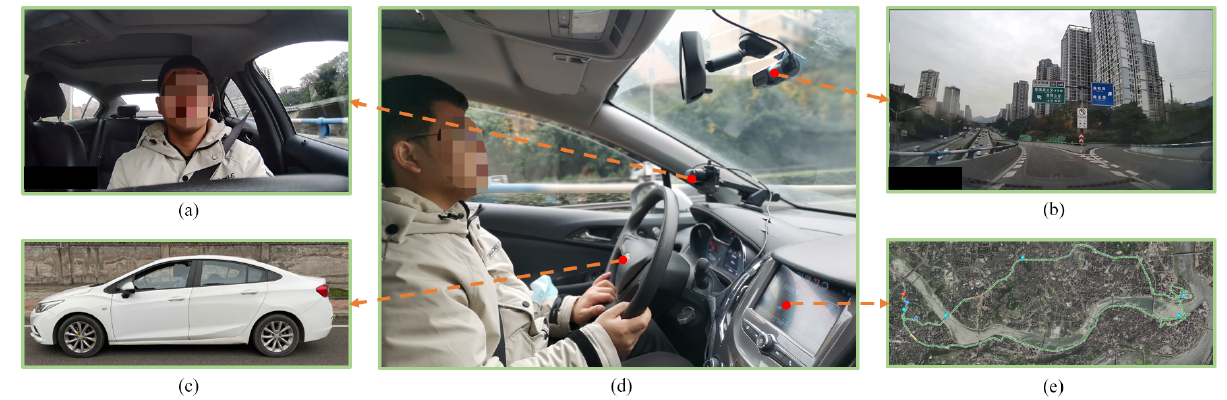
Figure 2. Experimental setup of on-road driver facial expression dataset collection: ( a ) driver facial expression recording, ( b ) road scenario recording, ( c ) experimental vehicle, ( d ) experiment setup, ( e ) navigation of the test